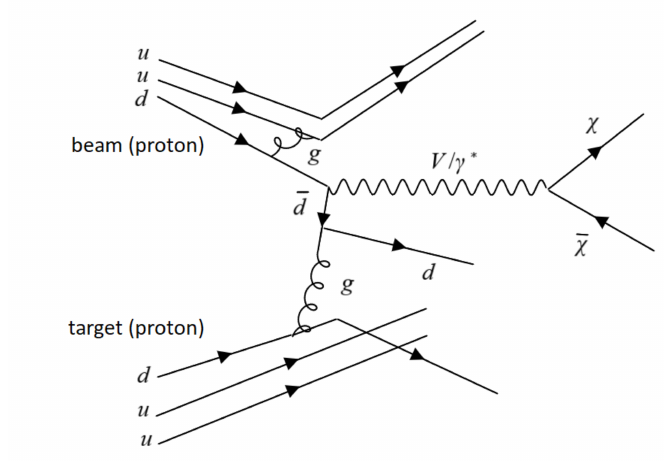
Figure 1. Scheme of the Drell-Yan process with the production of an LDM